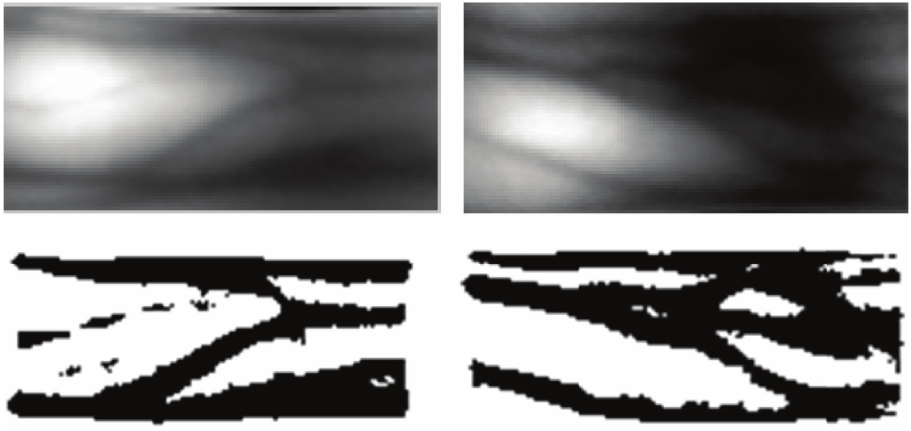
Figure 7: Segmentation images using Niblack